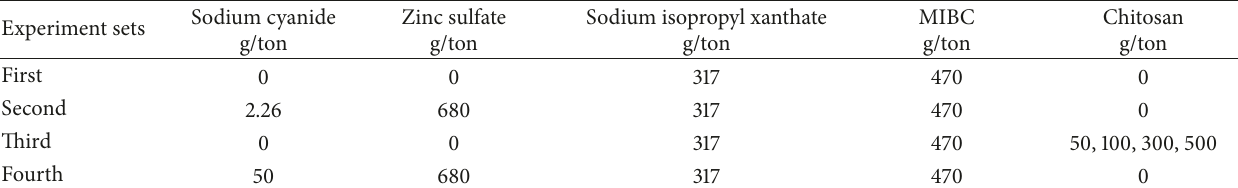
Table 1: Reagent used in the different sets of flotation experiments.